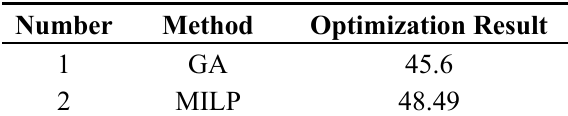
Table 5. The comparison about the 24-h optimization results without implementing RHC based on prediction